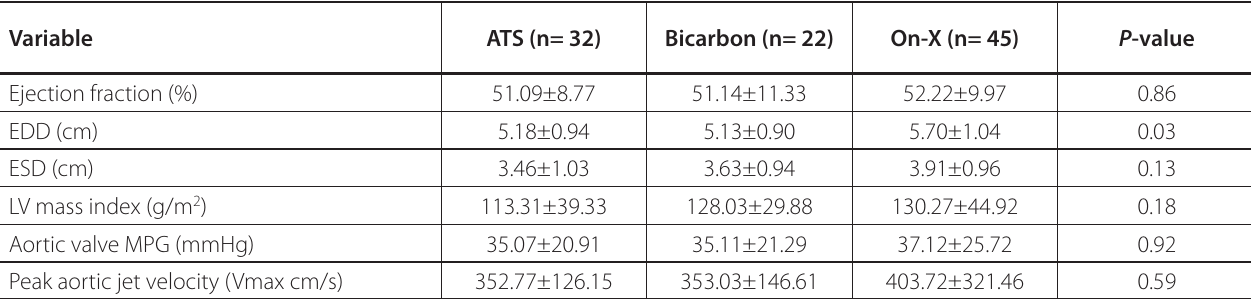
Table 2 . Preoperative echocardiographic data.